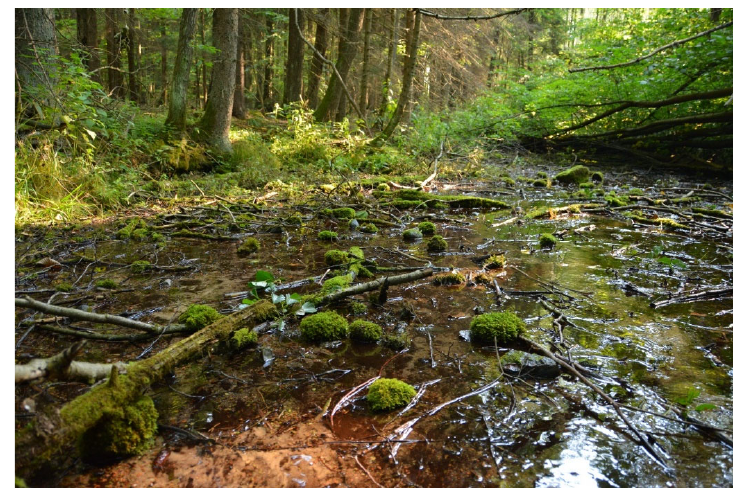
Figure 4. Rheocrene in the Migówka valley (Pstr ą gownia, spring No. 22).